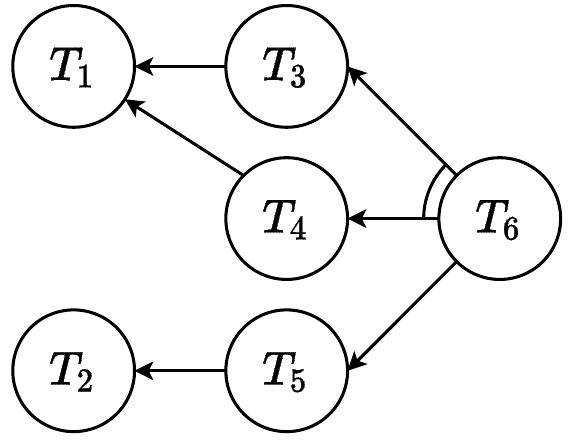
Figure 1. AND/OR graph representation. The unlinked edges represent the OR relations, while the ones connected with an arc represent the AND relations. For example, in the figure, T 6 can be executed after both T 3 and T 4 or after only T 5